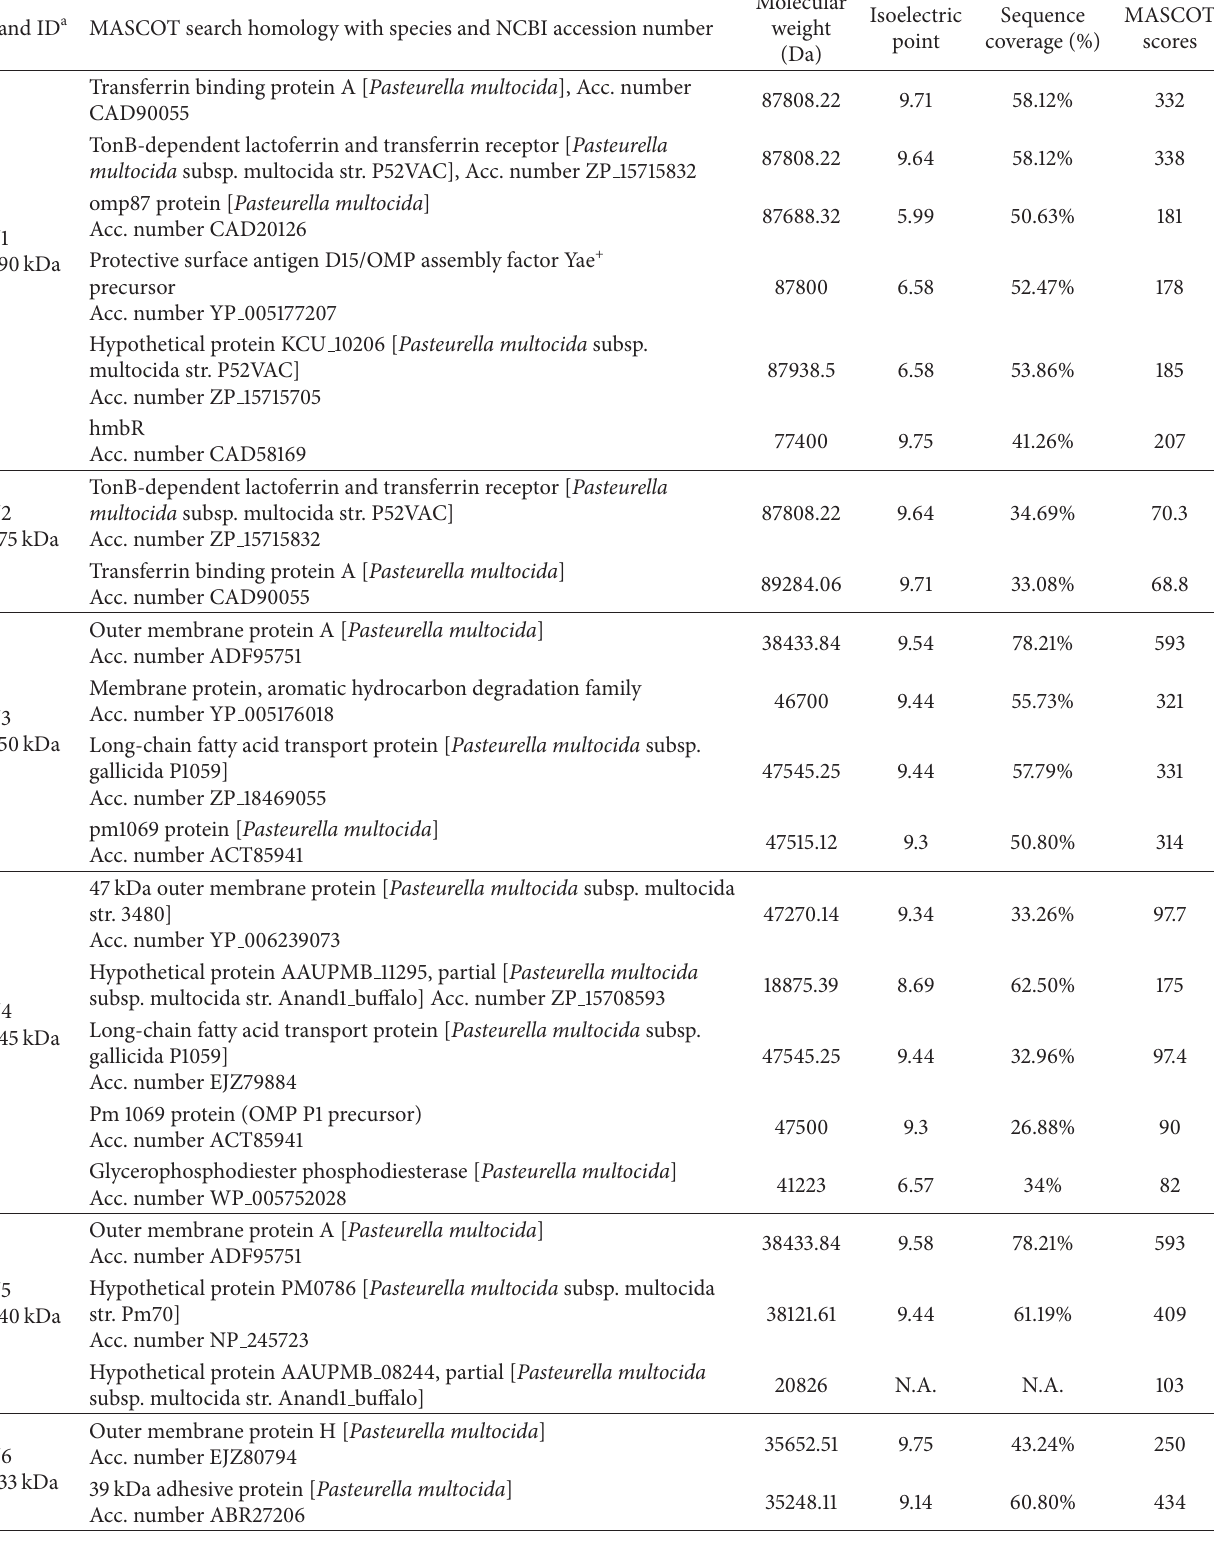
Table 1: Outer membrane proteins of Pasteurella multocida serotype B:2 identified by Mascot and BLASTP analysis. Band ID a MASCOT search homology with species and NCBI accession